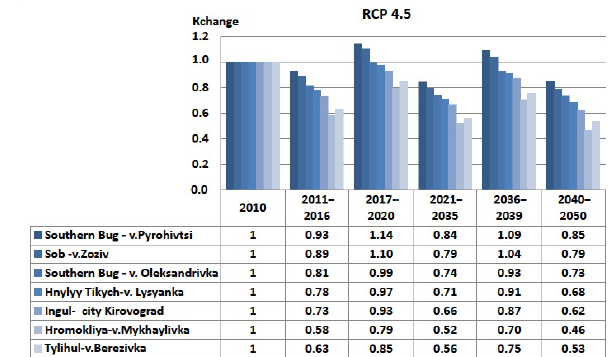
Figure 5. Expected average annual values k ch for taking into ac- count the influence of climate change on the maximal runoff of spring flood of the rivers of the Southern Bug basin using the model RACMO2, scenario RCP4.5